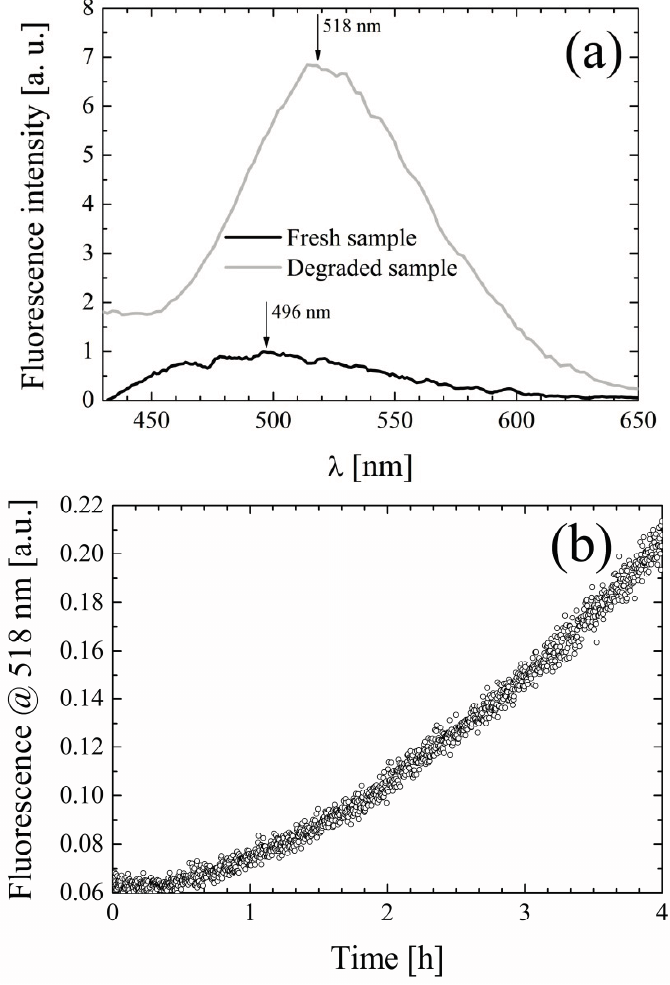
Figure 6. ( a ) Fluorescence emission spectra of fresh (black) and photodegraded (gray) CYV in acetonitrile; ( b ) Increment of fluorescence at 518 ± 2 nm in time upon irradiation at 370 ± 2 nm with ≈ 400 μ W/cm 2